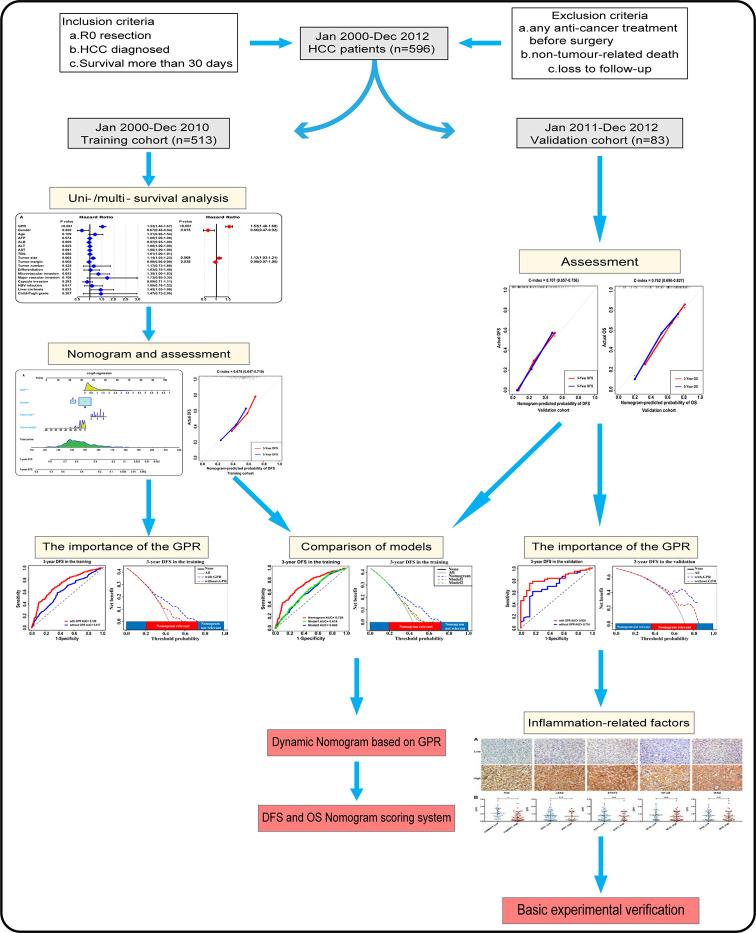
Flowchart of the analysis. GPR, gamma‐glutamyl transpeptidase‐to‐platelet ratio; HCC, hepatocellular carcinoma.